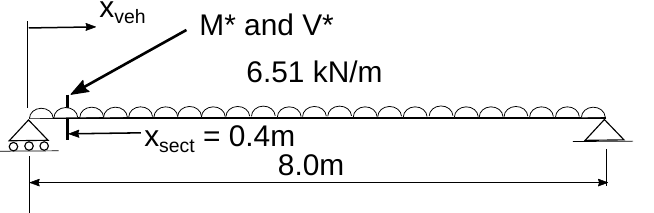
Figure 1. Simply-supported bridge beam with factored self-weight.